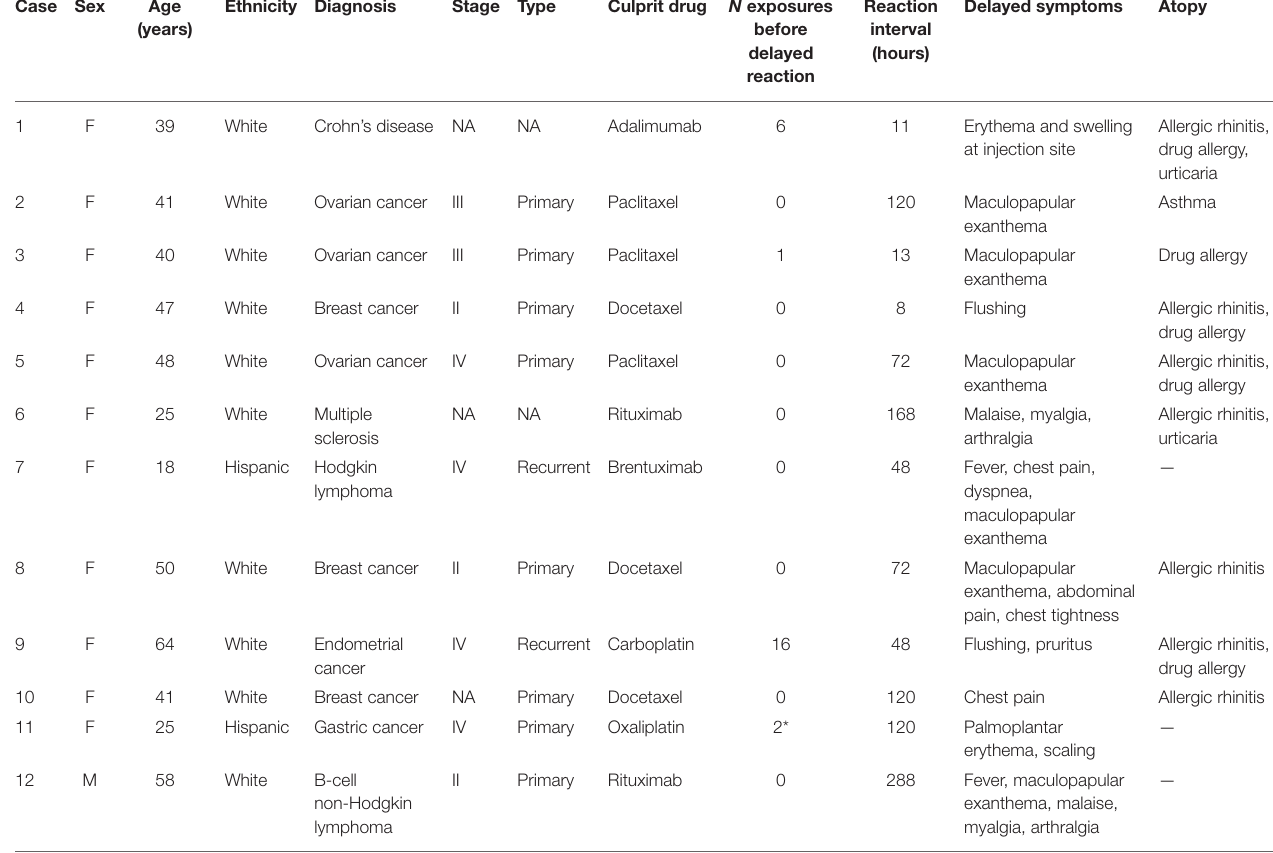
TABLE 1 | Characteristics of included patients and non-immediate drug hypersensitivity reactions. Case